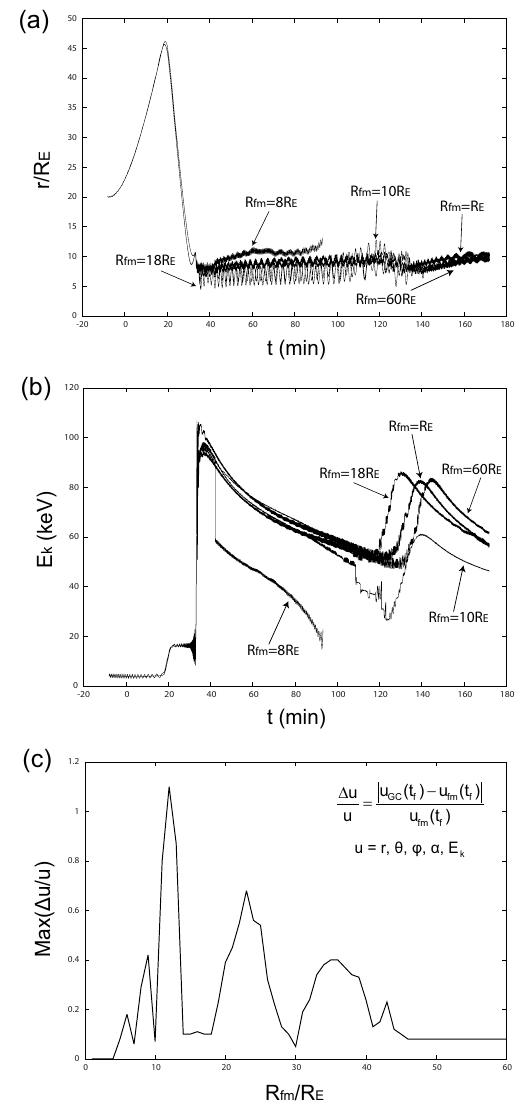
Figure 5. Application of the model interchanging technique in test- particle computations for different values of the threshold radius: (a) r vs. t , (b) E k vs. t , and (c) maximum relative error vs. R fm .